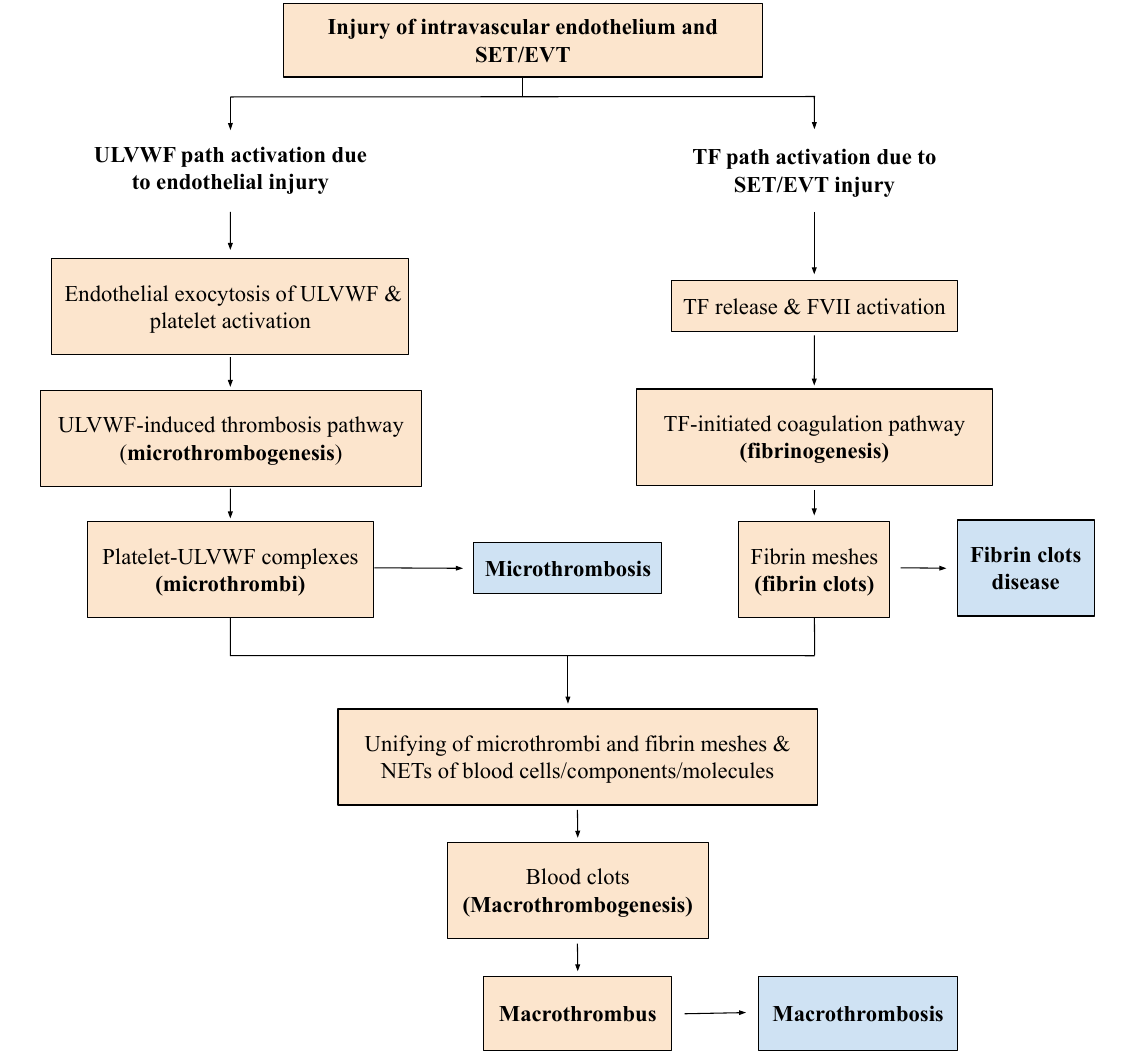
Figure 2. Normal in hemostasis in vivo based on “two-path unifying theory” (reproduced and modi- fied with permission from the Chang JC. Thrombosis Journal. 2019;17:10). Following a vascular injury, the hemostatic system in vivo activates two independent sub-hemostatic paths: microthrombotic (ULVWF path) and fibrinogenetic (TF path). Both are initiated by the damage of ECs and SET/EVT due to external bodily injury and traumatic intravascular injury. In activated ULVWF path from EC damage, ULVWF multimers are released and recruit platelets, which produce microthrombi strings via microthrombogenesis, but in activated TF path from SET/EVT damage, released TF activates FVII. The TF–FVIIa complexes produce fibrin meshes/fibrin clots via fibrinogenesis of the extrinsic coagulation cascade. The final path of in vivo hemostasis is macrothrombogenesis, in which microthrombi strings and fibrin meshes become unified together with incorporation of NETs, including red blood cells, neutrophils, DNAs, and histones. This unifying event, “macrothrombogenesis”, promotes the hemostatic plug and wound healing in external bodily injury, and produces macrothrombosis in intravascular injury. Abbreviations: EA-VMTD: endotheliopathy-associated vascular microthrombotic disease: ECs: endothelial cells; EVT: extravascular tissue; NETs: neutrophil extracellular traps; SET: subendothelial tissue; TF: tissue factor; ULVWF: ultra-large von Wil- lebrand factor multimers.